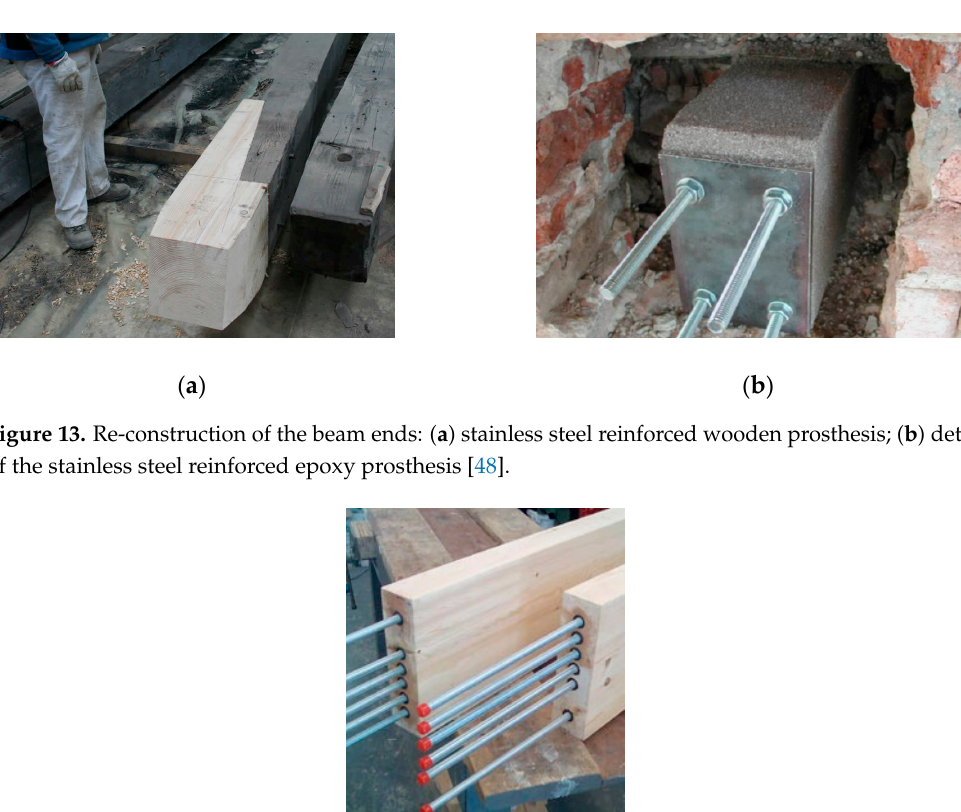
Figure 14. Re-construction of joist or beam ends with stainless steel rods [43].